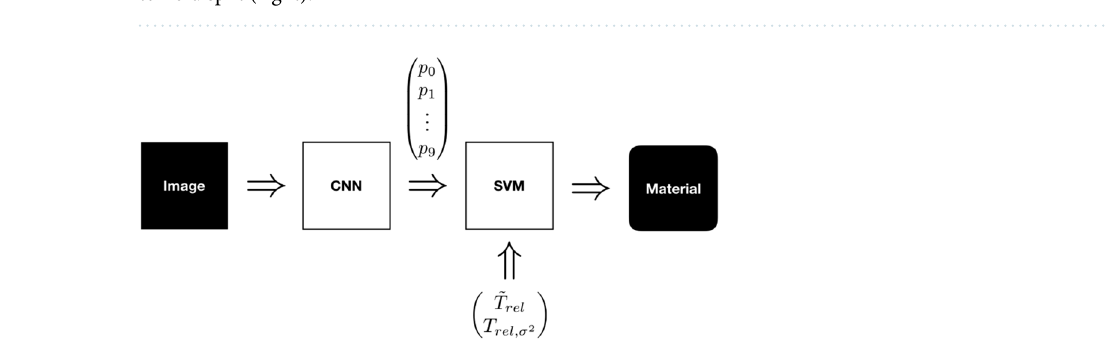
Figure 5. Algorithm pipeline: The CNN extracts and classifies VIS features from a RGB Image. The Softmax outputs ppp , the median relative temperature ˜ T rel and the variance T rel, σ 2 are part of the feature vector. A SVM merges these features for classification and predicts the resulting material.